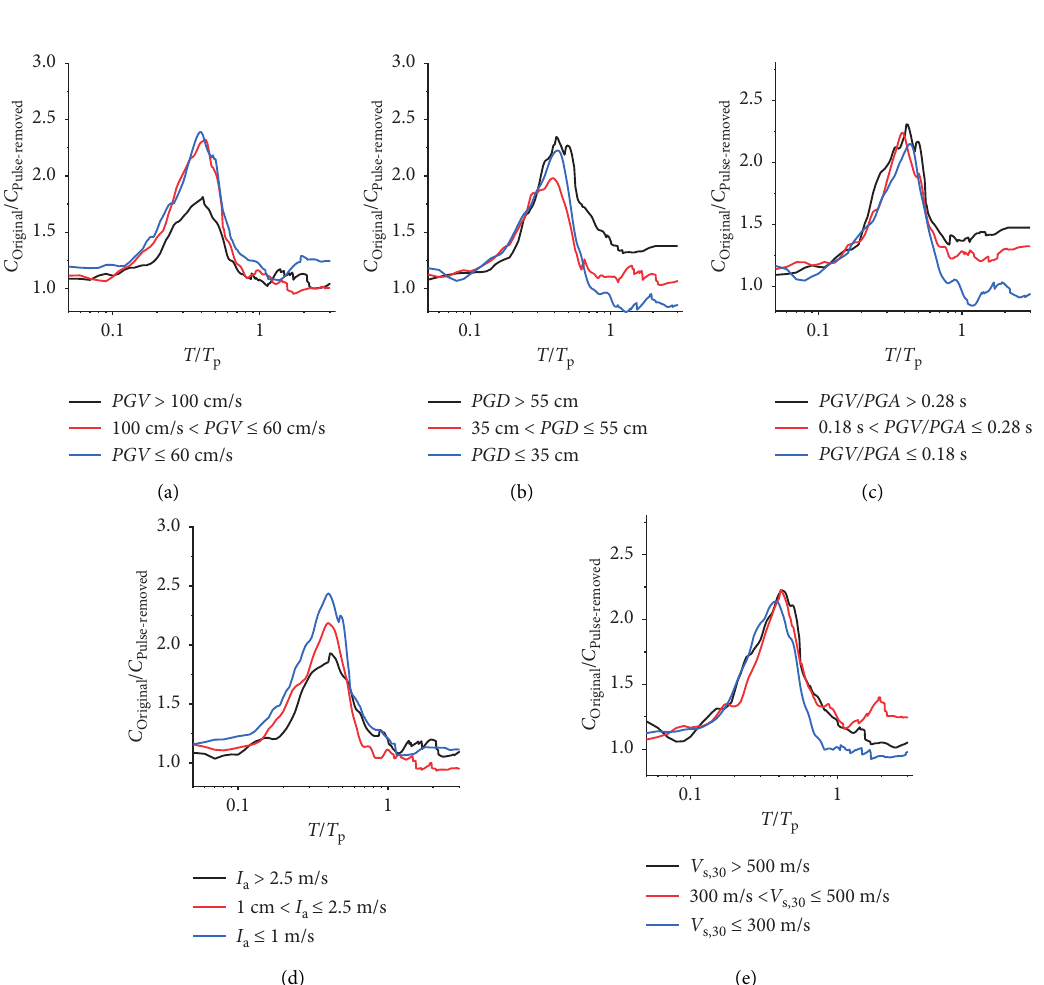
Figure 13: Comparison of the mean ratios of the inelastic displacement ratios ( µ � 6) for the original ground motions to those of the pulse- removed parts for the recordings in different (a) PGV, (b) PGD, (c) PGV/PGA, (d) I a , and (e) V s ,30